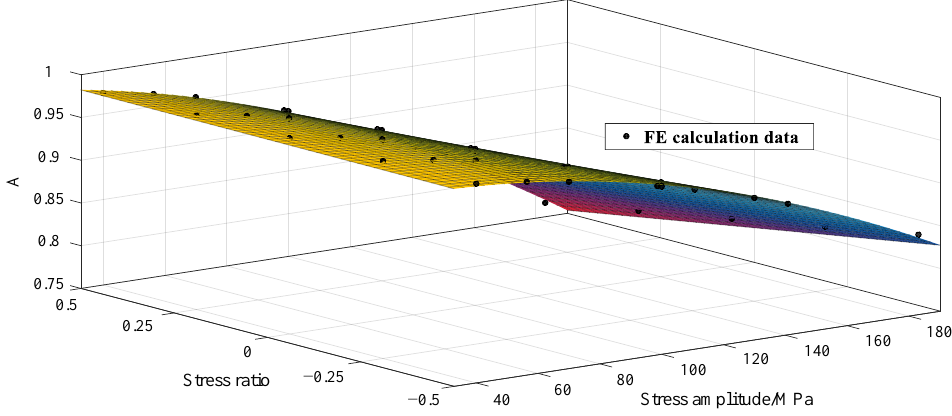
Figure 19. Comparison between numerical simulation and formula prediction.